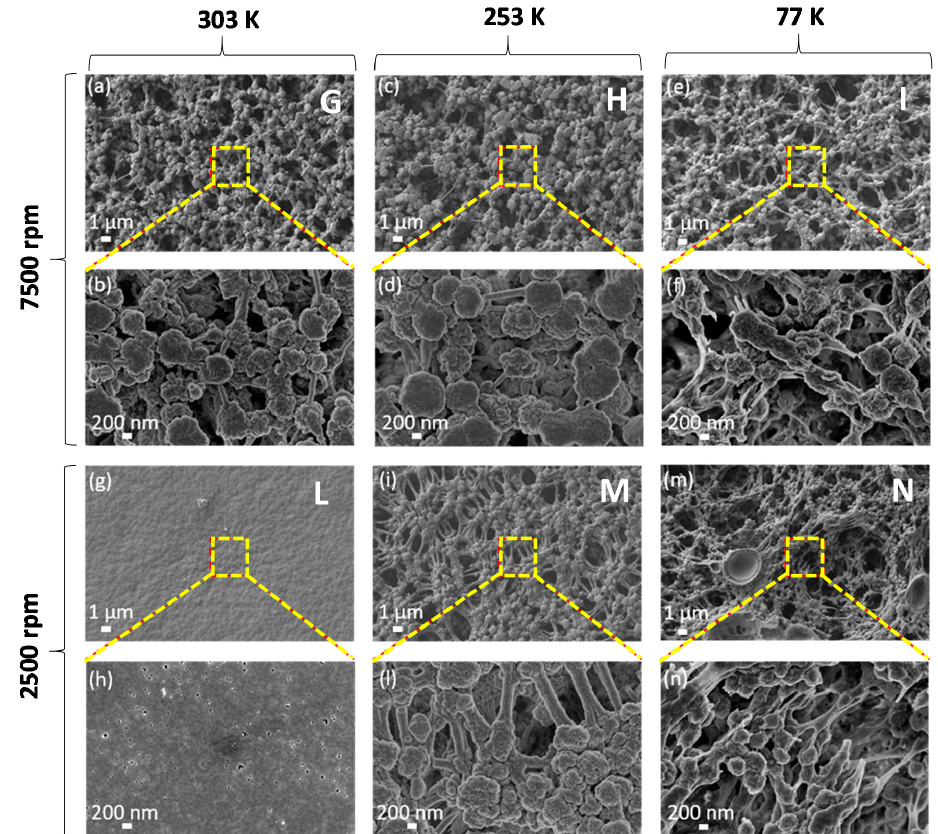
Figure 3. FE-SEM low-magnification ( a , c , e , g , i , m ) and high-magnification ( b , d , f , h , l , n ) micrographs of PVDF films with polymer content of 30 wt.%., produced at spin-coater rotation speed of 7500 rpm (samples G, H, I) or 2500 rpm (samples L, M, N), and quenched at 303 K in water (samples G, L) or